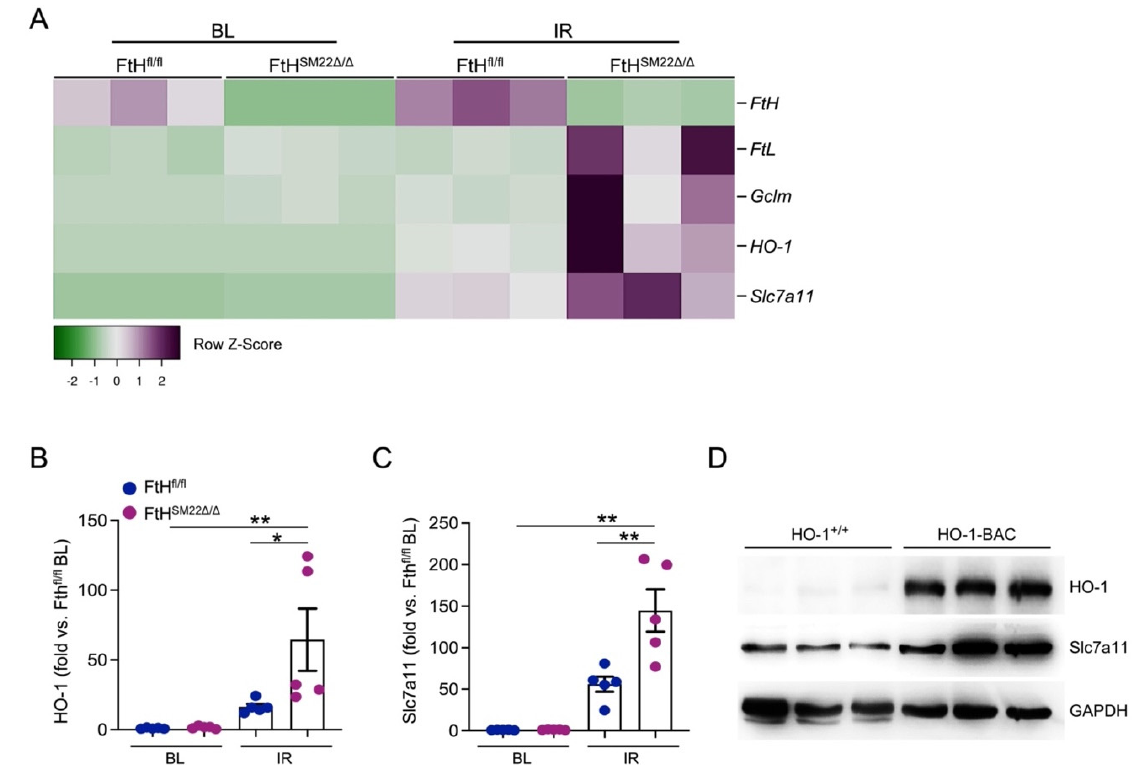
Figure 8. Heme oxygenase-1 (HO-1) counteracts FtH deficiency by upregulating the antiporter critical for minimizing ferroptosis, Slc7a11. ( A ) Heatmap demonstrating genes with anti-ferroptotic properties that are differentially expressed in FtH SM22 Δ / Δ hearts following IR compared to FtH fl/fl following IR. Results was extracted from RNA-sequencing data under BL and following IR conditions from both genotypes. The differentially expressed genes were identified based on absolute fold change of two or more and adjusted p < 0.05. Note the marked upregulation of Slc7a11 and HO-1 in FtH SM22 Δ / Δ hearts in response to IR. ( B , C ) Results of RNA-sequencing were independently verified for HO-1 ( B ) and Slc7a11 ( C ) using RT-PCR. * p < 0.05 and ** p < 0.01. n = 5/genotype/condition. ( D ) Western blot analysis of HO-1 wildtype (HO-1 +/+ ) and HO-1 overexpressing (HO-1 BAC) hearts under homeostatic conditions illustrating markedly higher levels of HO-1 and Slc7a11 expression in HO-1 BAC mice compared to controls (HO-1 +/+ ). GAPDH was used as loading